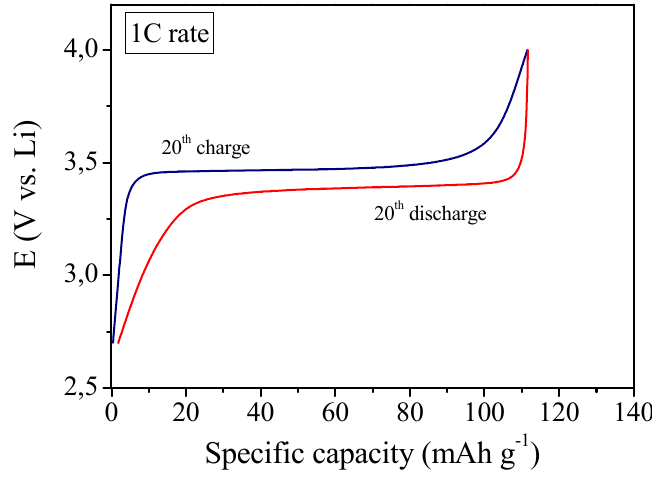
Figure 8. Ambient temperature galvanostatic charge-discharge profiles of the lithium polymer cell assembled by sandwiching the MC-PE reinforced polymer electrolyte /C cathode and a Li metal anode, at 1C current between a LiFePO 4